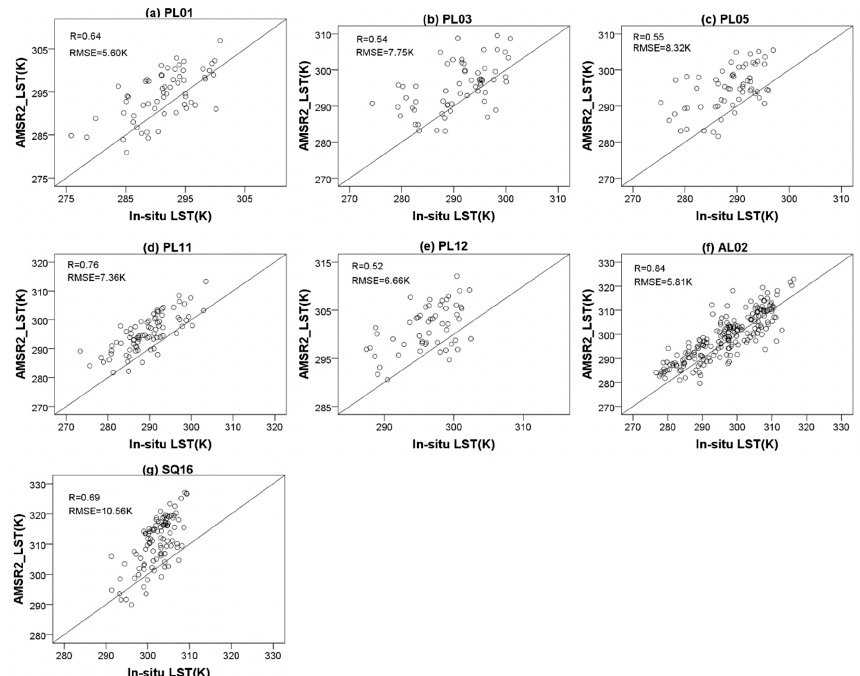
Figure 14. Comparison between estimated LST and in situ soil temperature at each site. ( a ) PL01. ( b ) PL03. ( c ) PL05. ( d ) PL11. ( e ) PL12. ( f ) AL02. ( g ) SQ16.